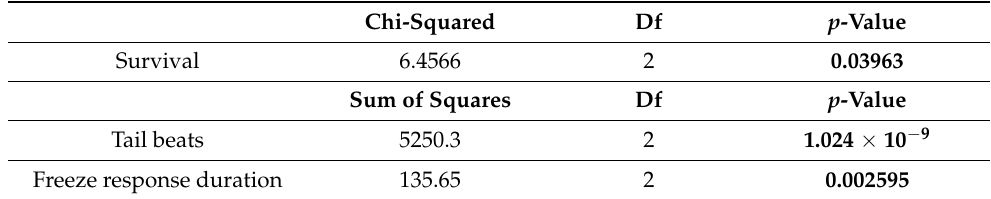
Table 3. Analysis of deviance table (Type II tests) for the generalized mixed models for survival, average number of tail beats, and freeze response duration of shark embryos exposed to control, deoxygenation, and hypoxia. Values of p < 0.05 are shown in bold.